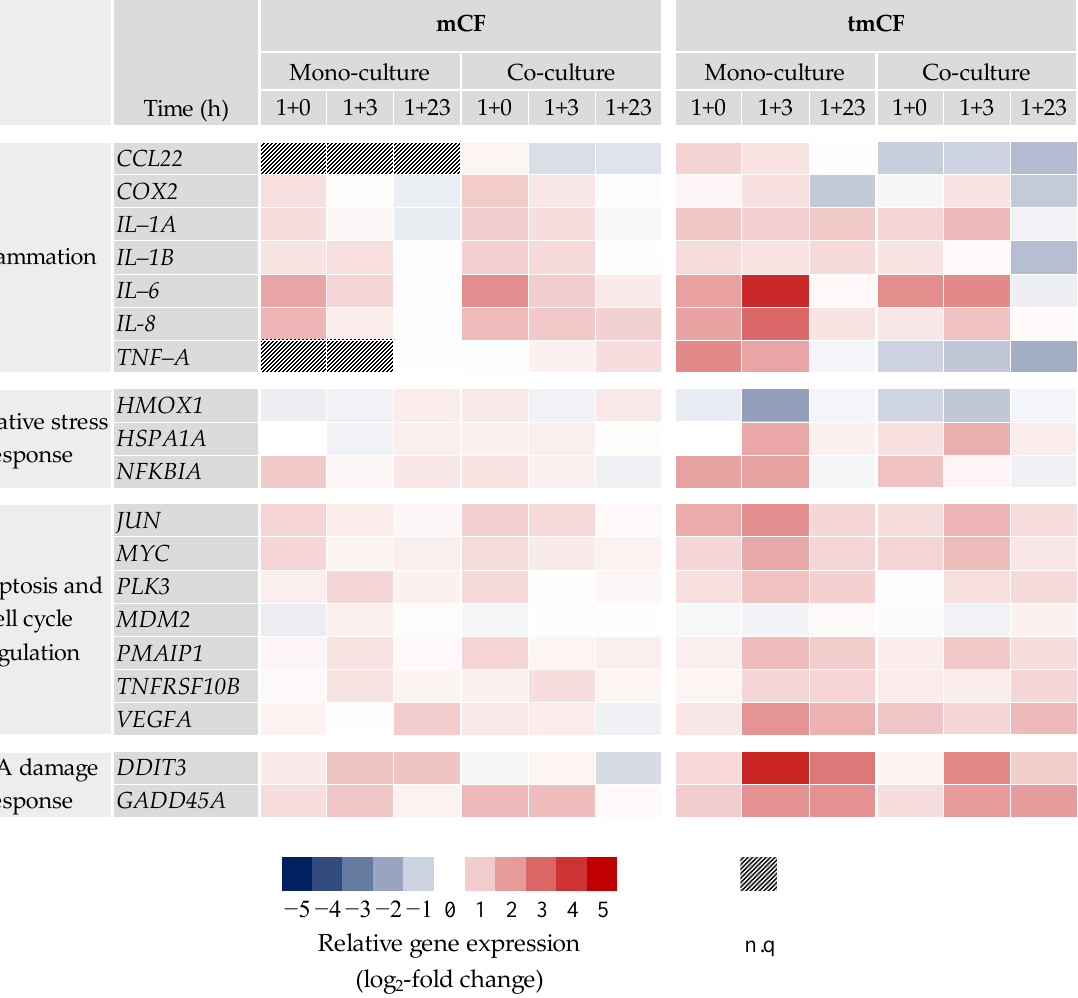
Figure 4. Gene expression profiles of BEAS-2B mono- and BEAS-2B/dTHP-1 co-cultures after exposure to mechanically (mCF) or thermo-mechanically treated CF (tmCF). Both cell culture models were exposed to CF samples with average surface doses of 7.00 ± 1.25 µg/cm 2 (mCF, ( A , C )) or 6.55 ± 1.96 µg/cm 2 (tmCF, ( B , D )) for 1 h and post-incubated for 0, 3, or 23 h. The results are depicted as the log 2 -fold change in the relative gene expression. A red color represents the induction; a blue color, the repression of a gene. The mean values of at least three independent experiments are displayed. n.q.: not quantifiable due to low expression levels.